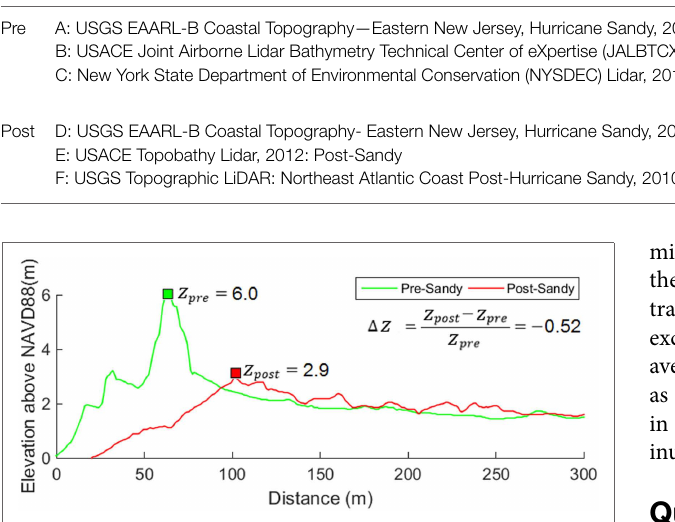
FIGURE 6 | Ground elevation above NAVD88 along a transect in Ortley Beach ( Figure 2B ) before (green) and after (red) Hurricane Sandy.